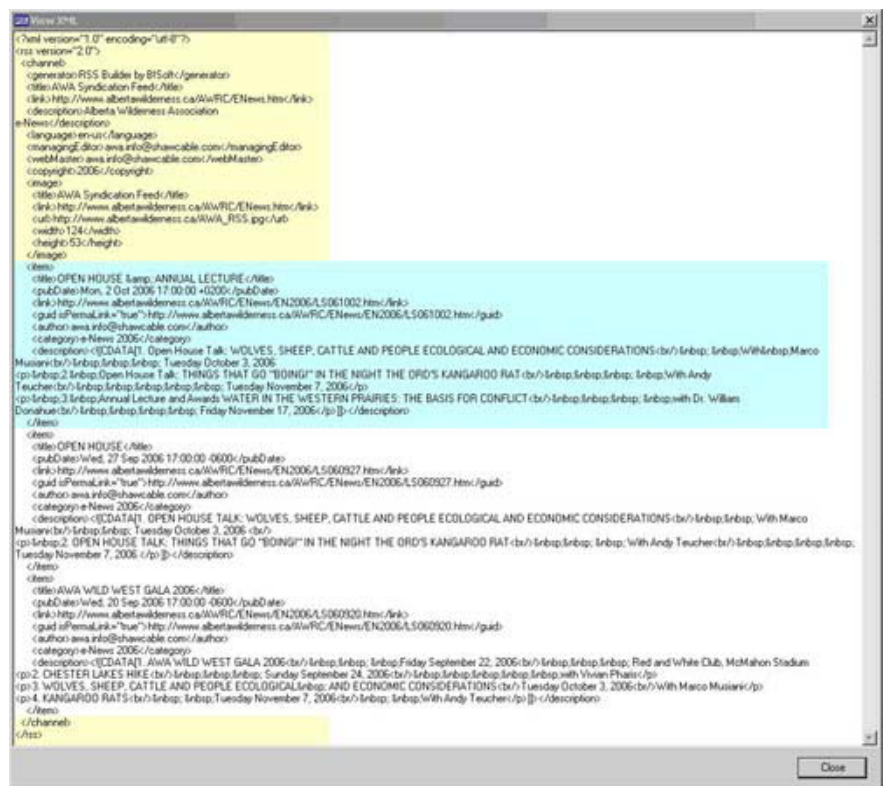
Figure 3. The XML preview window in RSS Builder displays machine readable format created from field entries in Figure 2. The XML highlighted in yellow represents then channel fields from the left area displayed in Figure 2. The XML highlighted in blue represents the first item fields from the right area displayed in Figure 2. Figure 1 is the resultant presentation for the